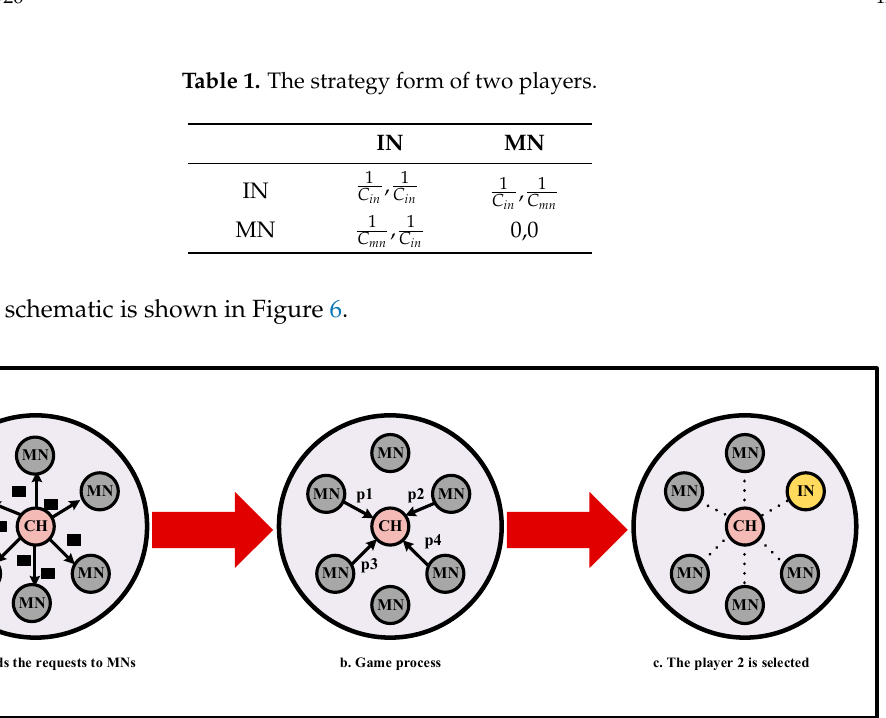
Figure 6. The process of the IN selection.